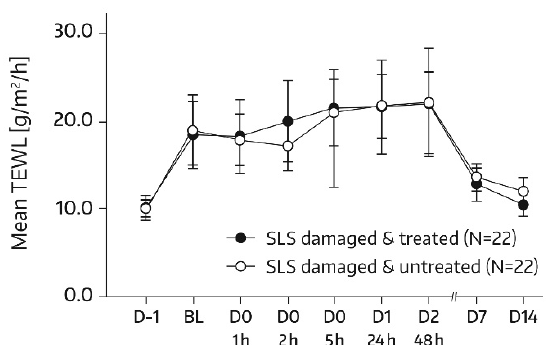
Figure 4. Results from TEWL measurements in untreated SLS-damaged skin and SLS-damaged skin undergoing a single application of Emollient 1 (first 48 h) followed by once-daily application for 12 days. The values are presented as mean ± SD. SLS challenge started on day -1 and ceased 24 h later (30 min before BL assessment).BL = Baseline TEWL value before first product application; D = day; h = hour; SLS = sodium lauryl sulfate.